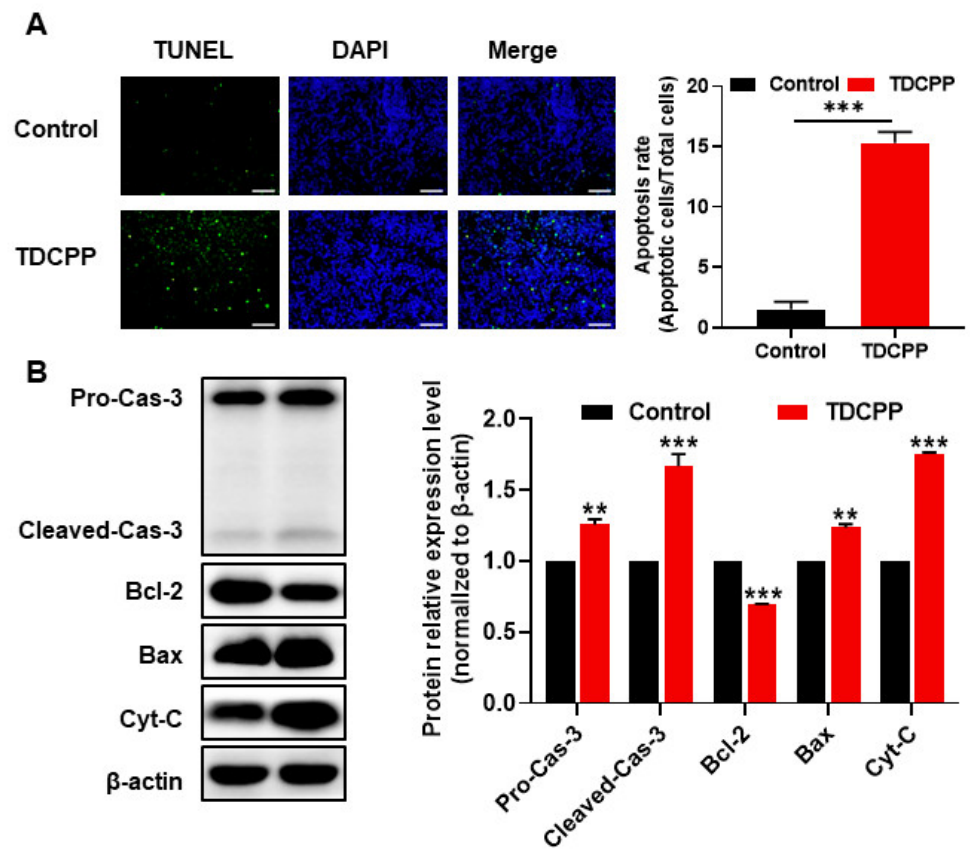
Figure 3. TDCPP-induced apoptotic cell death in the spleen. ( A ) The spleens of both groups of mice were examined by TUNEL assay, and the apoptotic rates of TUNEL-positive cells were calculated. ( B ) Detection of caspase-3/Bcl-2/Bax/Cyt-C protein expression levels using Western blotting to determine that TDCPP exposure leads to apoptosis in mice spleen tissue via the mitochondrial apoptosis pathway. ** p < 0.01, *** p < 0.001, compared with control group.